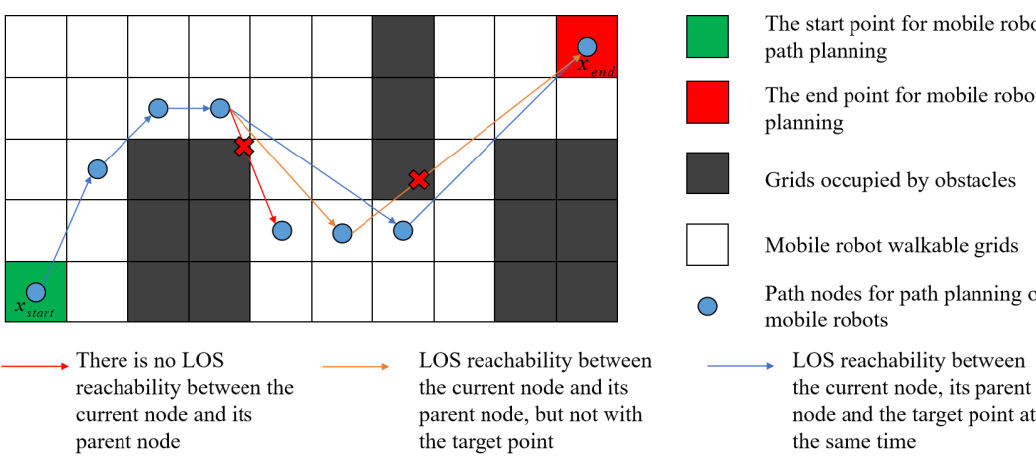
Figure 7. Mobile robot workspace based on grid slice.